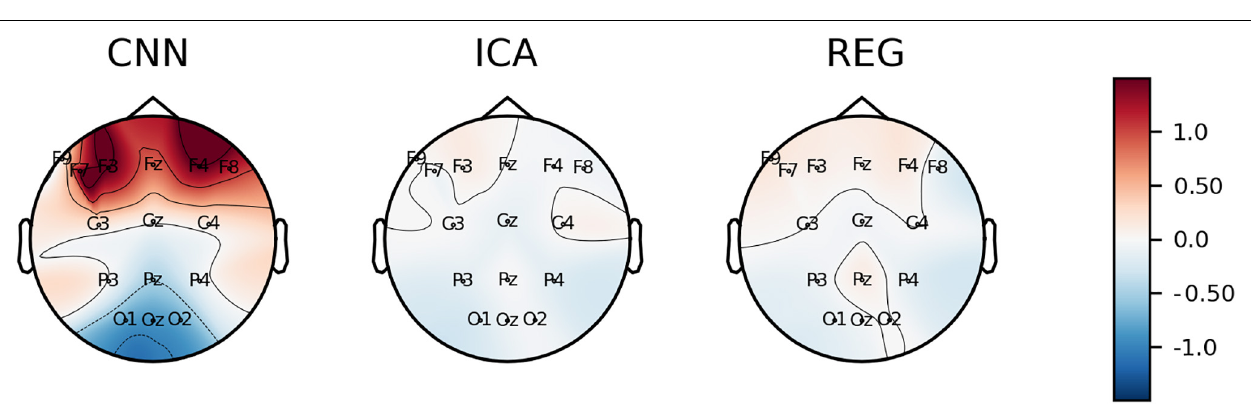
FIGURE 12 | The average value of Skewness coefficient plotted on the surface of the